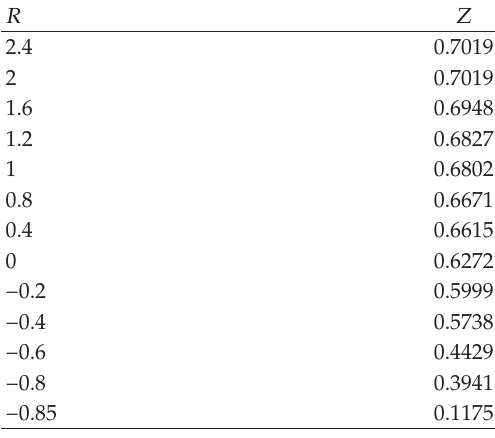
Table 5: The e ff ect of time delay (cid:2) compression (cid:3) coe ffi cient on the comprehensive performance of LSSC.